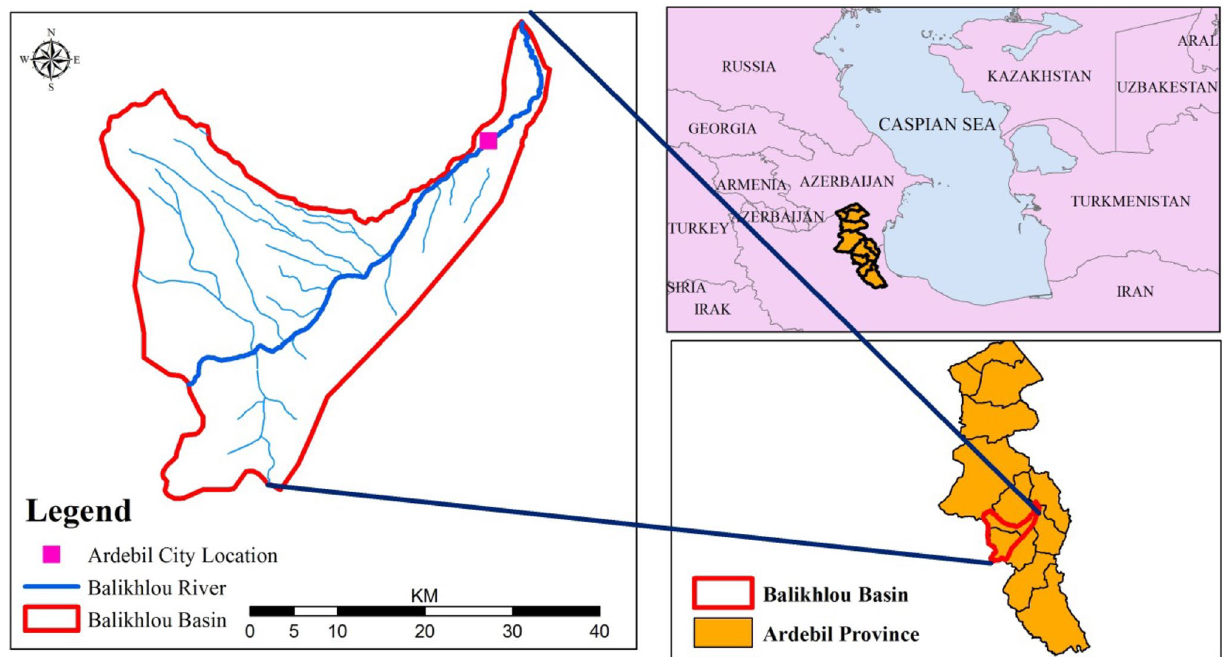
Fig. 1 The location of the study area in Ardabil Province and